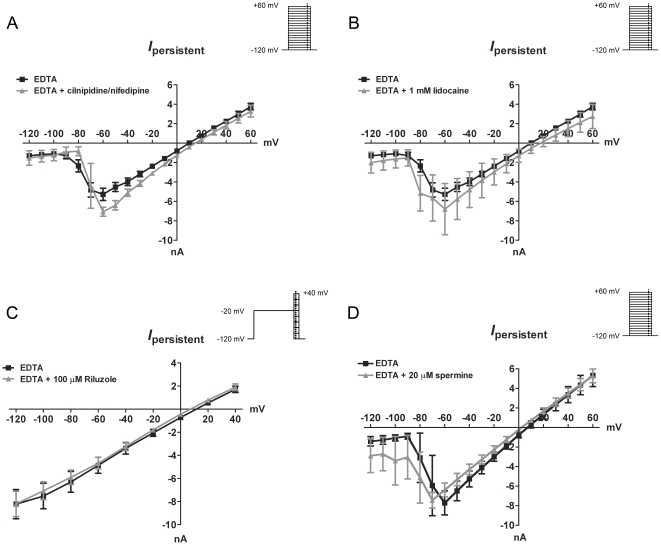
Pharmacological characterization of IDF responses in vagal neurons.Mean ± S.E.M. The current-voltage relationship of the IDF in bath solution containing 5 mM EDTA (0 Ca2+, 0 Mg2+) in the absence (black squares; n = 24) and presence of different ion channel blockers (grey triangles). A, N-type and L-type CaV blockers; 10 µM cilnidipine and 10 µM nifedipine respectively (n = 4), B, 1 mM lidocaine (n = 4), C, 100 µM riluzole (n = 4) and D, 20 µM spermine (n = 8). Insets indicate the voltage-step protocol used. A, B and C show unpaired data, D shows paired data.